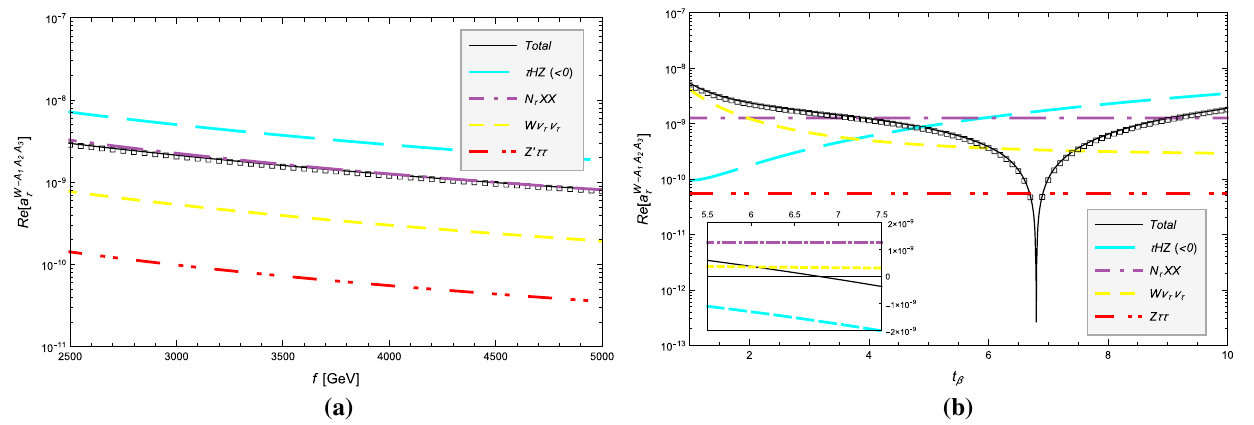
Fig. 8 Absolute value of the real part of the main partial contributions to a W − NP τ and the total sum as a function of f for t β = 9 ( left plot ) and as a function of t β for f = 4 TeV ( right plot ). For the remaining parameters of the model we use the values of Table 2. The contributions below the 10 − 10 level are not shown. All the contributions are positive